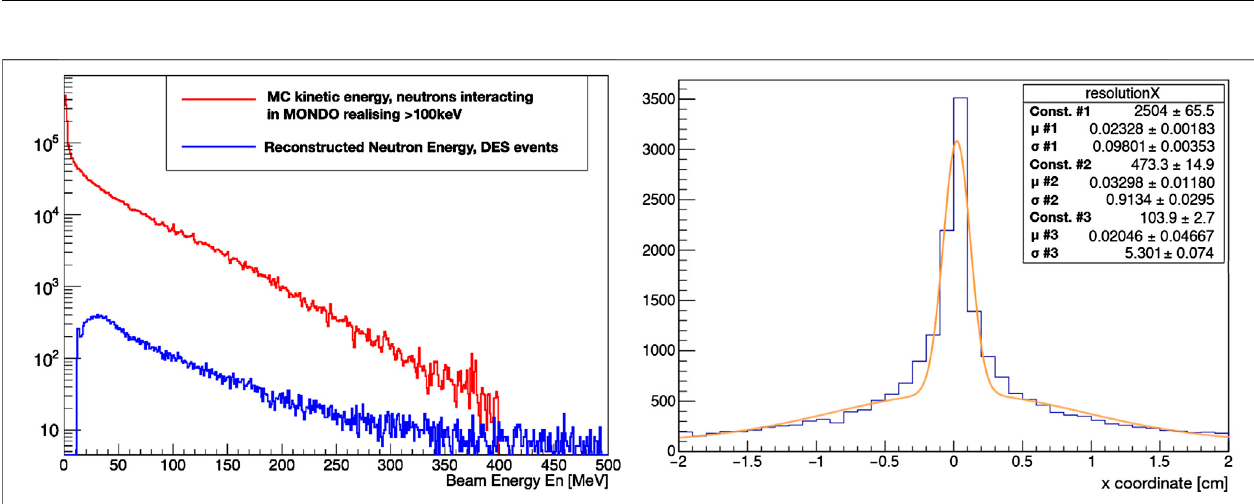
FIGURE 4 | (Left) Comparison between the simulated neutron spectrum generated from a 200 MeV 12 C ion beam on a PMMA target and the spectrum reconstructed by MONDO. (Right) Pro fi le of the reconstructed emission point at 20cm from MONDO detector. The distribution is symmetric for both x and y planes. Only the x plane is